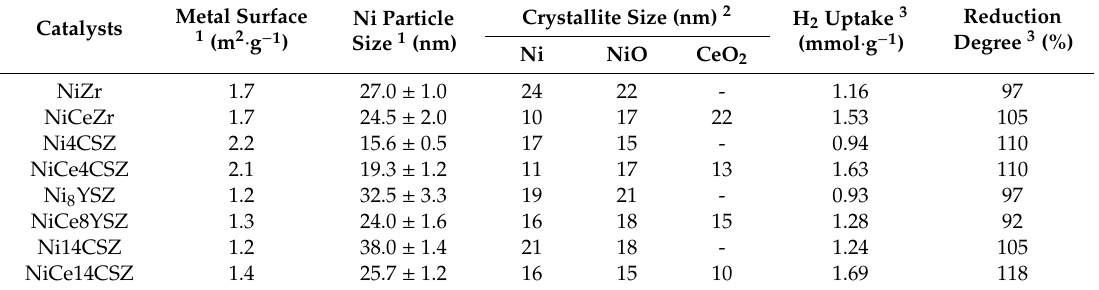
Table 2. Results from H 2 chemisorption, XRD line broadening, and H 2 -TPR experiments.